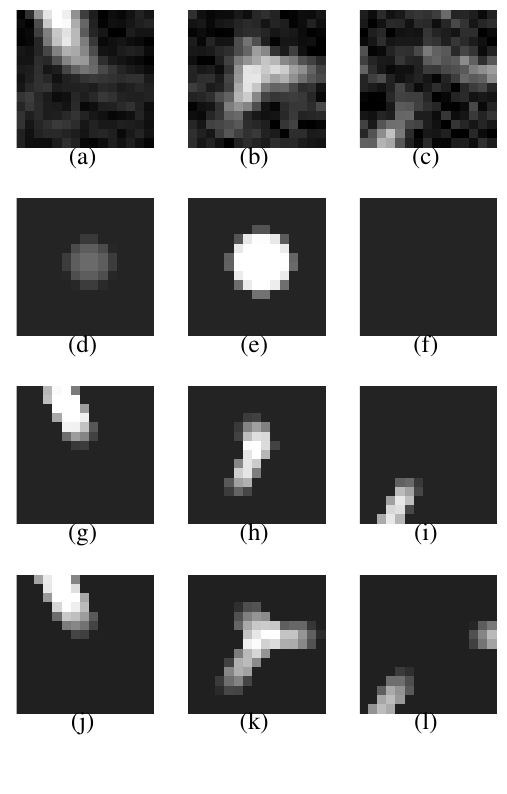
Figure 13. A VOI of the nodule candidate shown in Figure 12 and its templates.